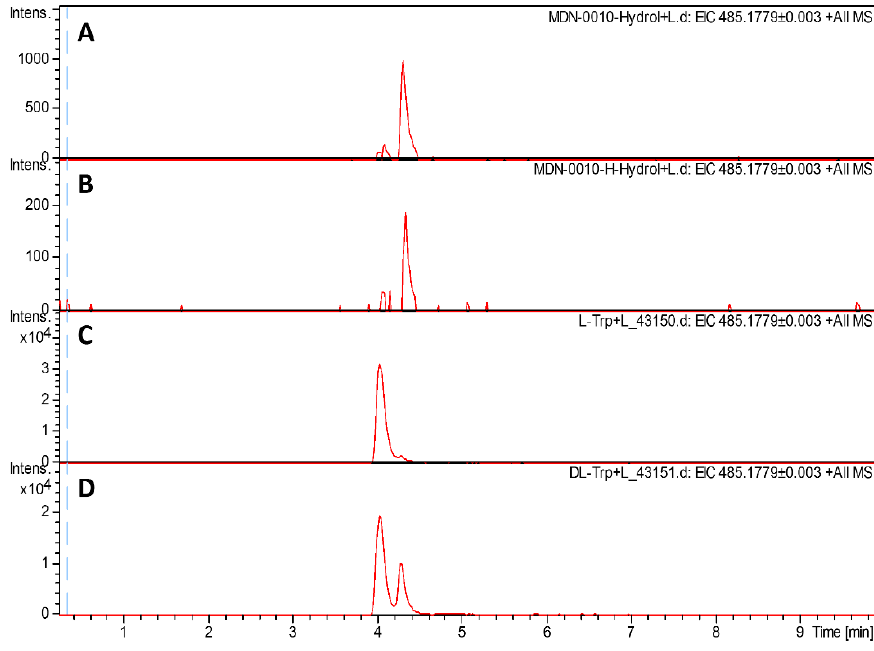
Figure 5. Marfey’s chiral analysis of the C-terminal tryptophan (Trp) using 1-fluoro-2,4-dinitrophenyl-5-L-valine-amide (L-FDVA). The LC-MS profile was monitored at 485.1779 m / z (M + H + of FDVA derivatives of Trp). ( A ) Humidimycin from strain S. humidus CA-100629, ( B ) humidimycin from S. coelicolor M1154 / pHUM cultures, ( C ) L-Trp standard. and ( D ) L-Trp + D-Trp